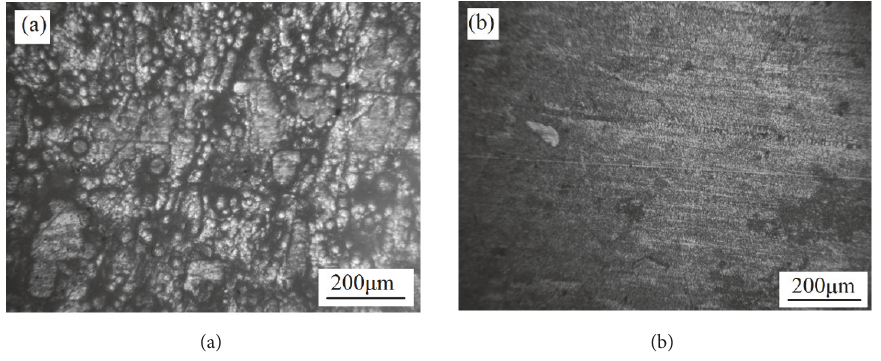
Figure 5: A metallographic image of the surface of the Ni coating after corrosion at view of 400 × : (a) without laser processed and (b) with laser